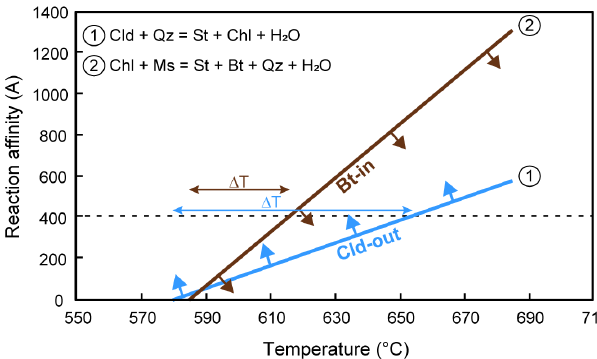
Figure 9. Reaction affinity vs. temperature ( A − T ) for the chloritoid-consuming and the biotite-forming reactions, calculated per mole of oxygen in the product porphyroblasts